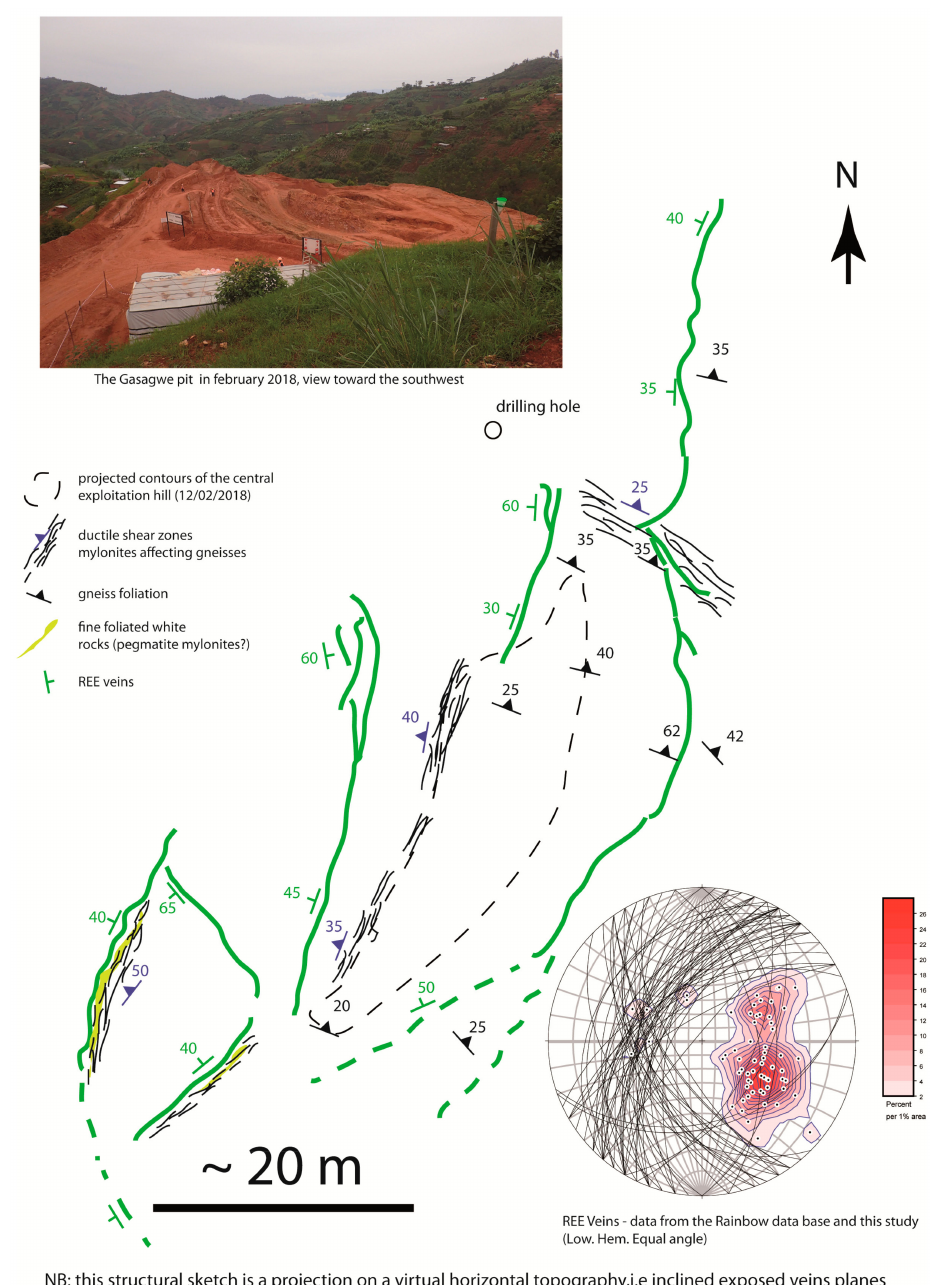
Figure 3. Structural sketch of the Gasagwe REE mine and stereogram of the REE-bearing veins (great circles and contoured